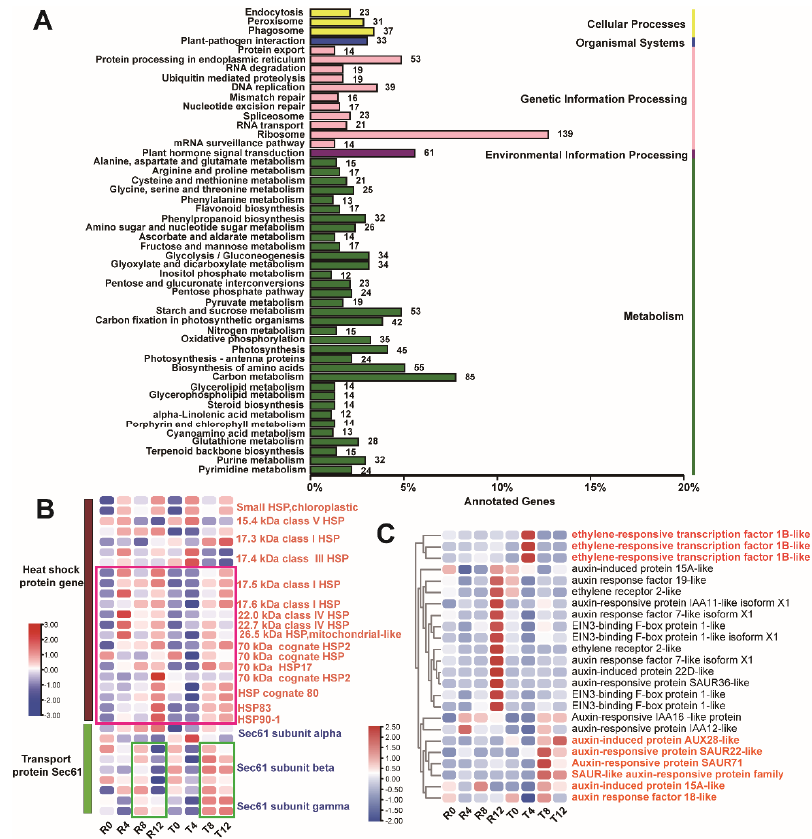
Figure 3. Analysis of the DEGs from the comparison of the two cotton cultivars. ( A ) KEGG pathway enrichment analysis; ( B ) expression profile of the DEGs in the protein processing in endoplasmic reticulum pathway; ( C ) expression profile of the DEGs in the plant hormone signaling transduction pathway.